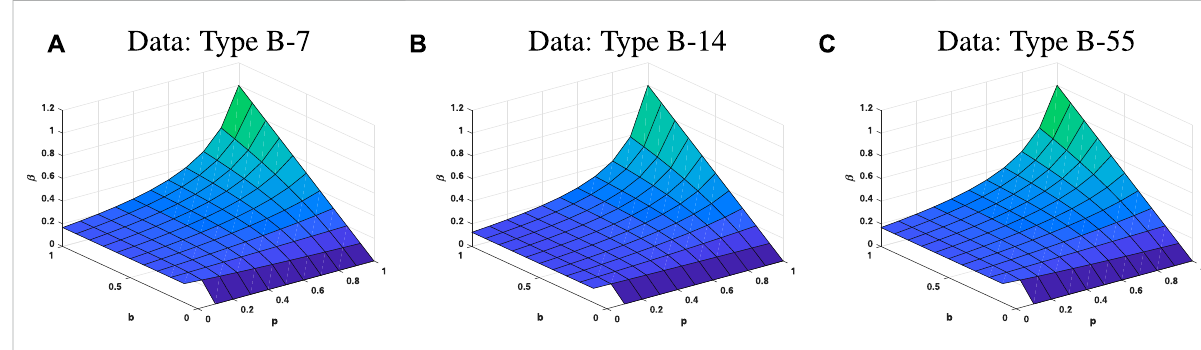
FIGURE 9 Sensitivity analysis of three parameters on the control reproduction number R c , these three parameters are β , p and b . The different color indicates the different value of the parameter β . The entire surface represents the control reproduction number satis fi es R c = 1. Above the surface represents R c > 1, and conversely, below the surface is R c < 1. (A – C) are sensitivity analyses of types B-7, B-14, and B-55, respectively.